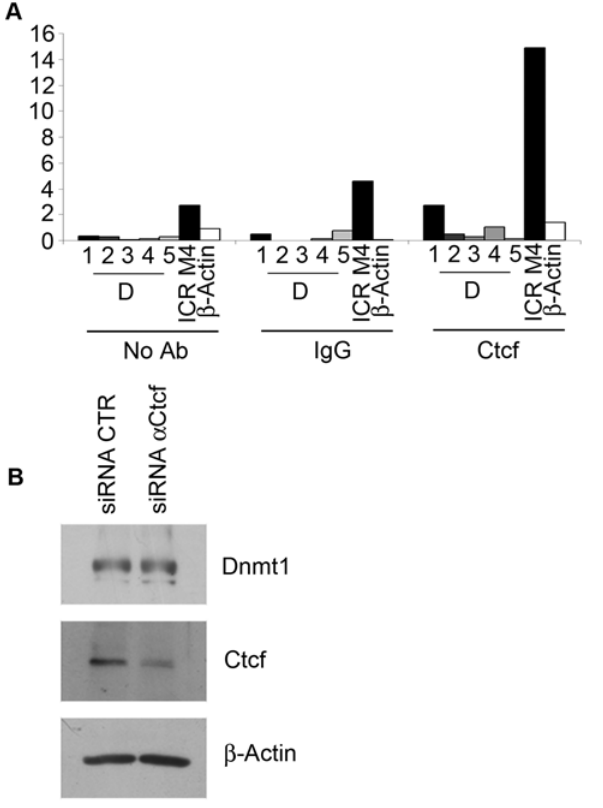
Figure 5. ChIP analysis of Dnmt1 promoter occupancy by Ctcf. A, ChIP was carried out with anti-Ctcf antibodies. The imprinting control region ICR M4 ( Igf2/H19 locus) was used as a positive control for Ctcf binding (For further specifications about control ChIPs and the set of primers used see legend to figure 4). B, Western Blot analysis of total cell lysates from L929 cells transfected with anti-Ctcf siRNA and detected with anti-Ctcf and anti-Dnmt1 antibodies. b -Actin served as endogenous